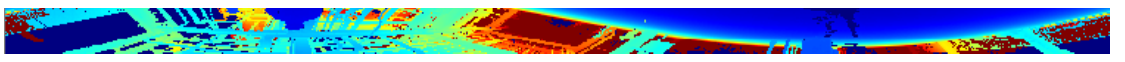
Figure 7. The 3D points generated by the Velodyne scanner are projected onto a 2D spherical grid. This way, we can exploit the adjacency in the 2D domain, e.g., to quickly find neighboring points in 3D.